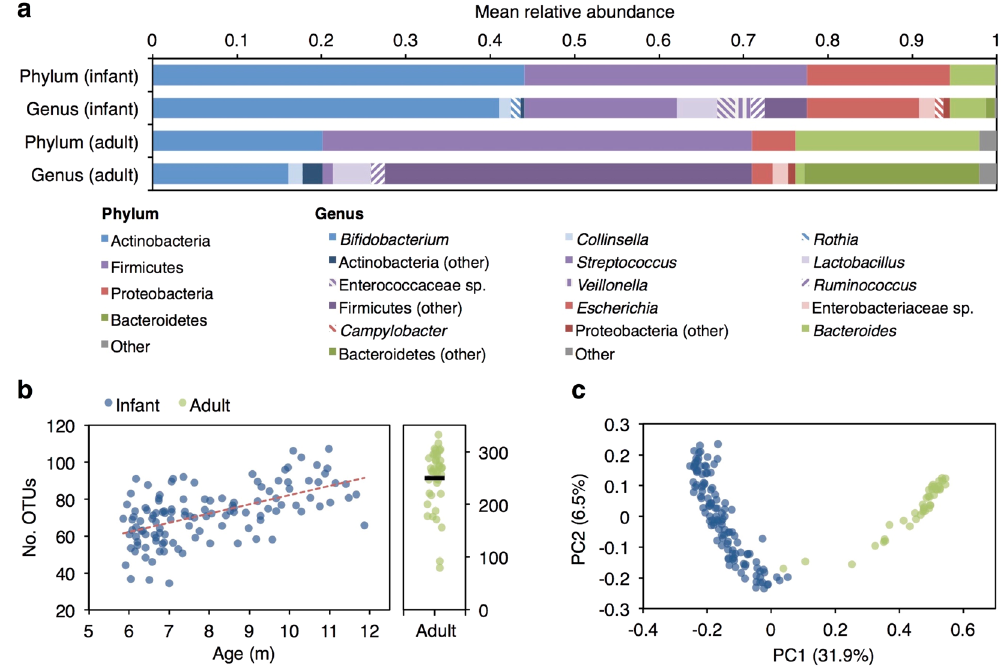
Figure 1. Composition of the bacterial microbiota at enrolment. ( a ) Mean relative taxon abundance at phylum and genus level among day-0 infant samples (n = 120) and adult samples (n = 40). Genera with a mean relative abundance of > 1% in infants are included. For categories labeled as ‘other ’ we include genera below this abundance threshold, including 11 taxa with a mean abundance of > 1% in adults. Overall, we observed 125 genera, of which 89 were present in infants and 85 were present in adults. ( b ) Number of OTUs by age. ( c ) Unweighted Unifrac distances, visualised via principal coordinates analysis, for day-0 infant samples and adult samples. Abbreviations: m, months; OTU, 97%-identity operational taxonomic unit; PC, principal